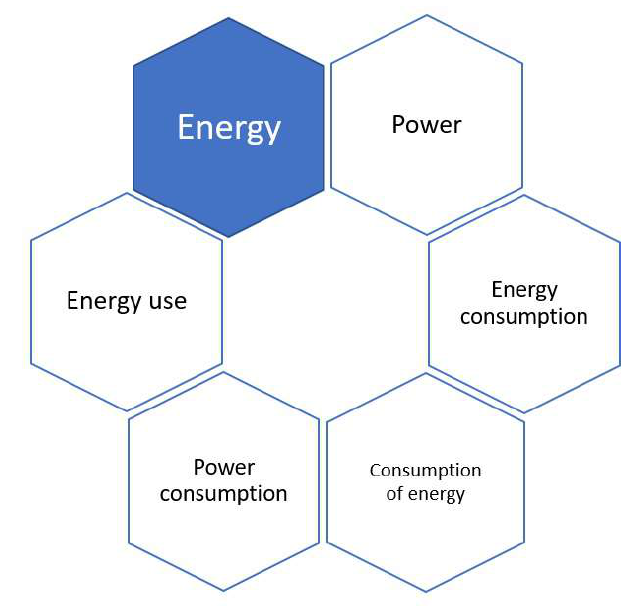
Figure 2. Synonyms for the “Energy”